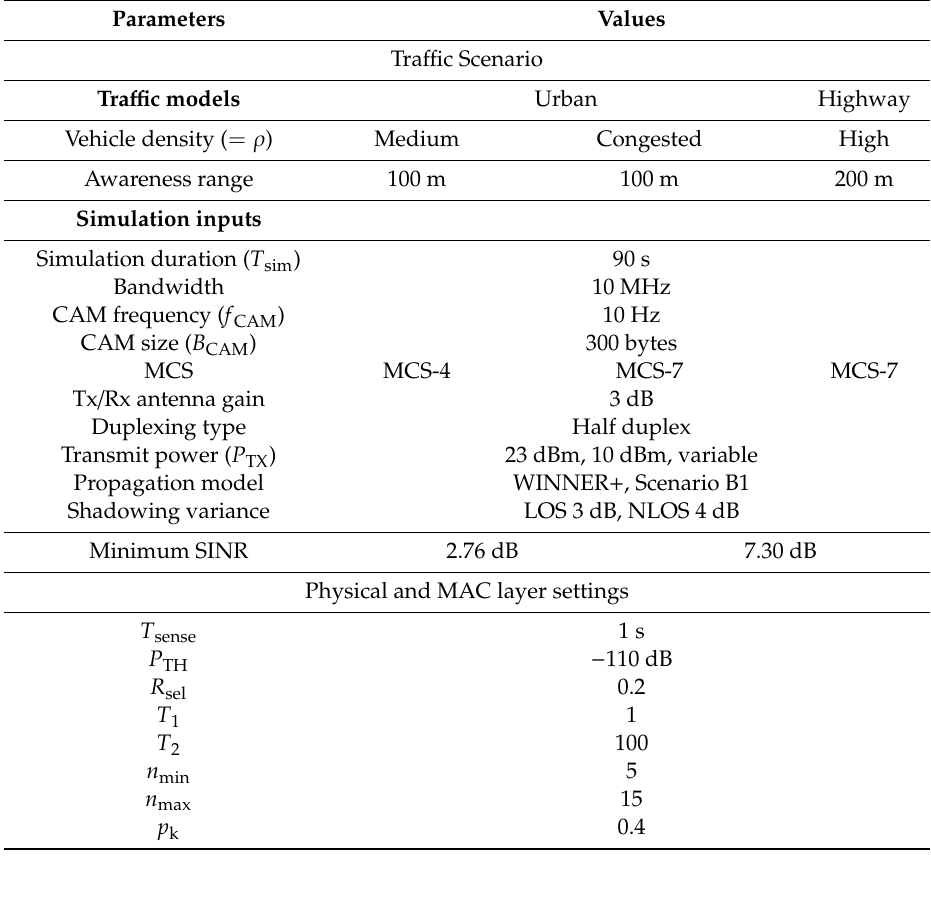
Table 3. Summary of parameters and settings for Simulation 2.